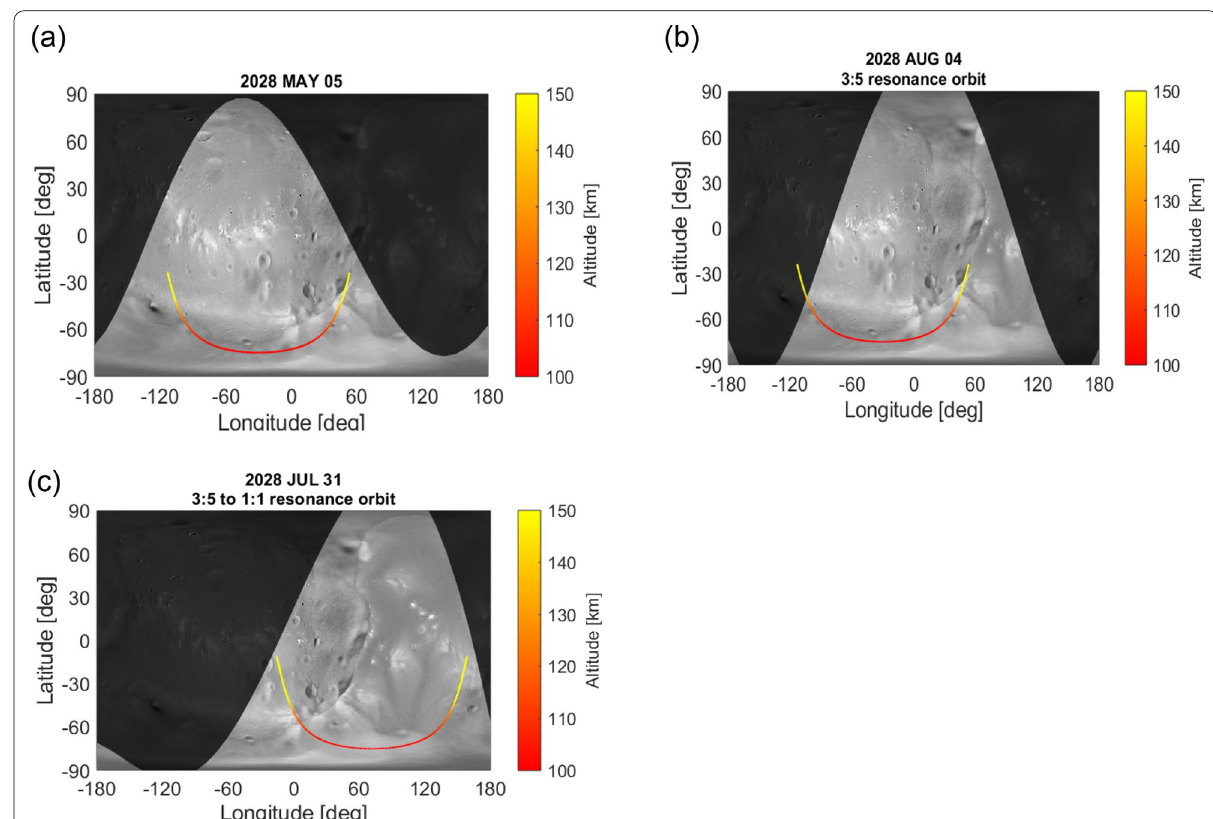
Fig. 19 Spacecraft’s ground track of the first flyby on a 3:5 resonance orbit ( a ), the last flyby on a 3:5 resonance orbit ( b ), and the last flyby if a change to a second 1:1 resonance is performed ( c